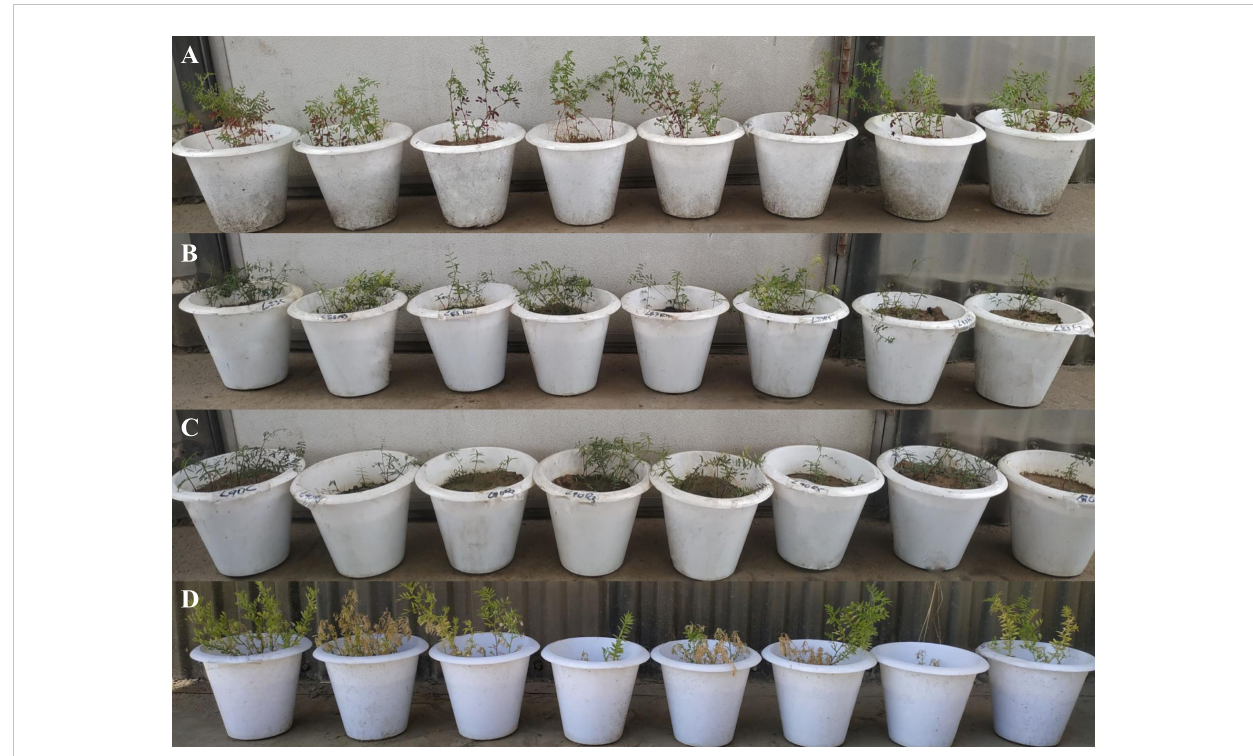
FIGURE 3 Pot evaluation of lentil accessions, (A) IC201561 (L65); (B) EC714243 (L83), (C) EC718238 (L90); and (D) L-9-12 (Susceptible check) against seven races of Fusarium oxysporum ( f ) sp. lentis . Pot in the left-hand corner is control followed by race 1 (MP-2), race 2 (UP-9), race 3 (RJ-8), race 4 (DL-